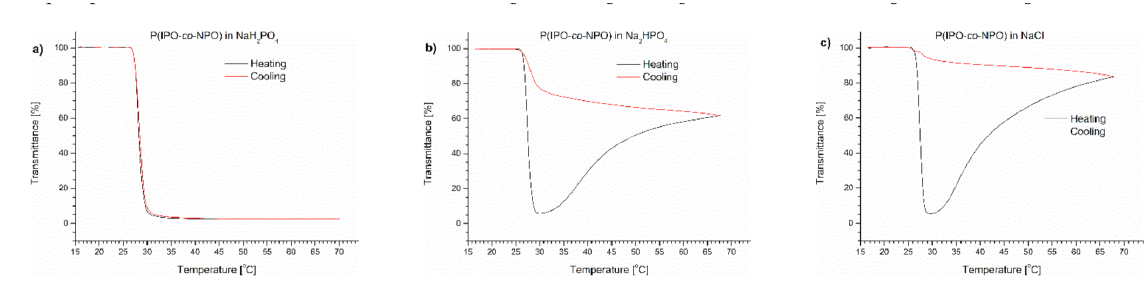
Figure 4. Transmittance versus temperature curves of P(IPO- co -NPO) solutions in ( a ) monosodium phosphate, ( b ) disodium phosphate, ( c ) NaCl. Total solute concentration: 0.5 g/L; heating/cooling rate: 1 ◦ C/min. Heating: black; cooling: red.